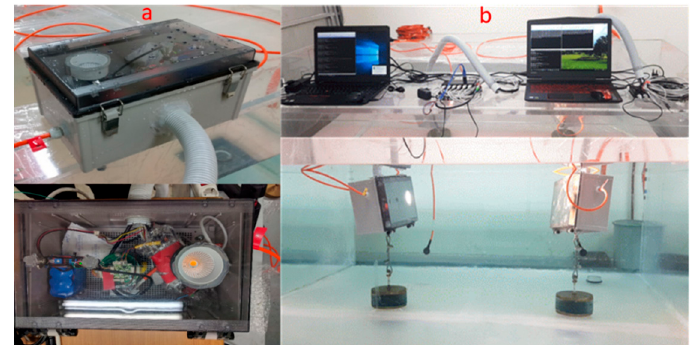
Figure 11 . Source to sink node routing using the medium selection mechanism.